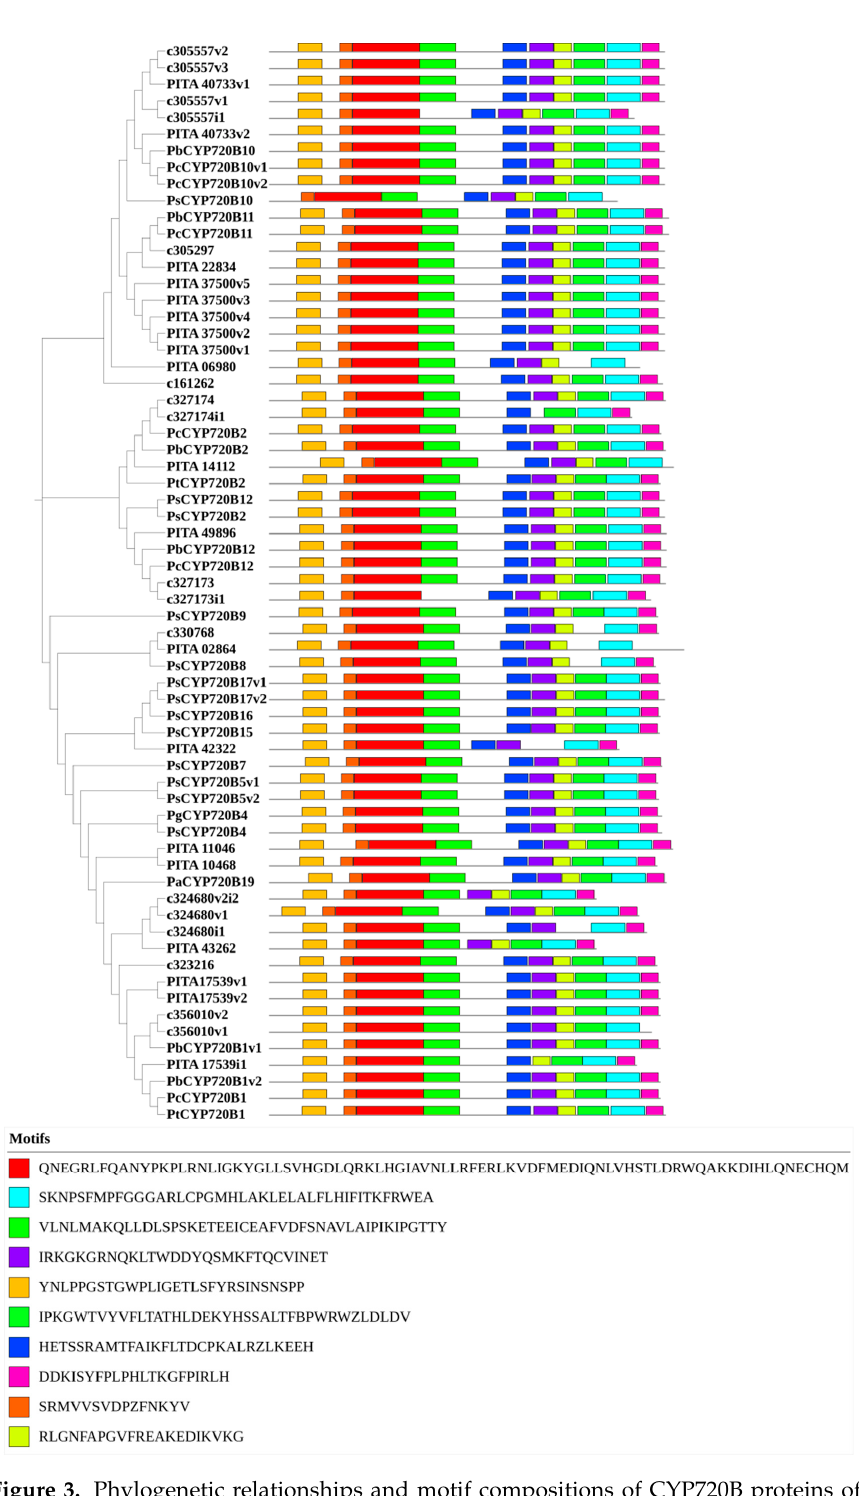
Figure 3. Phylogenetic relationships and motif compositions of CYP720B proteins of slash pine and loblolly pine identified in this study and previously characterized CYP720B in conifers. The gene names beginning with c and PITA stand for the CYP720B genes of slash pine and loblolly pine identified in this study, respectively. The detailed information of other CYP720B genes identified in previous studies was shown in Table A1. Left panel: An unrooted phylogenetic tree constructed using MEGA X by the neighbor-joining method. The proteins were clustered into four main clades. Right panel: distribution of conserved motifs in the CYP720B proteins. The different-colored boxes represent different motifs and their position in each CYP720B protein